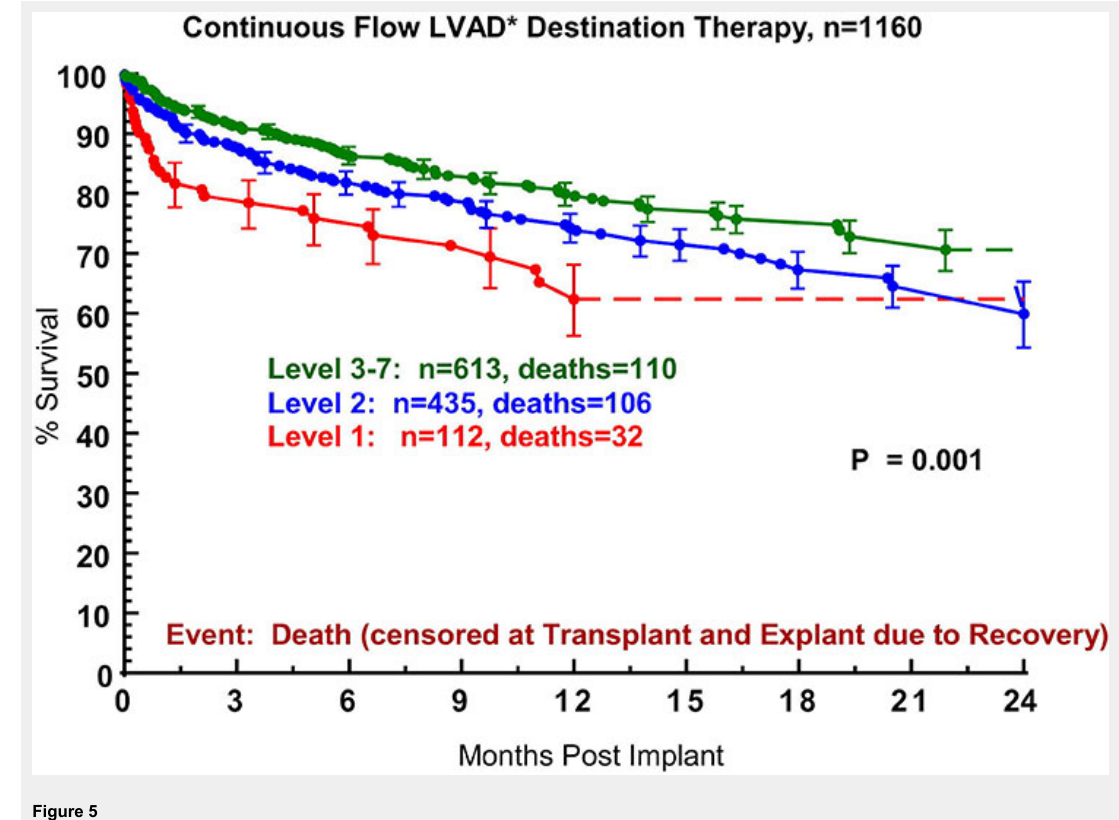
Figure 5 Actuarial survival after continuous-flow device destination therapy, stratified by INTERMACS level at the time of implant. INTERMACS, Interagency Registry for Mechanically Assisted Circulatory Support [20]. © 2012 Elsevier. Kirklin JK, Naftel DC, Pagani FD, Kormos RL, Stevenson L, Miller M, et al. Long-term mechanical circulatory support (destination therapy): On track to compete with heart transplantation? J Thorac Cardiovasc Surg. 2012;144:584‒603 [20]. Reprinted with kind